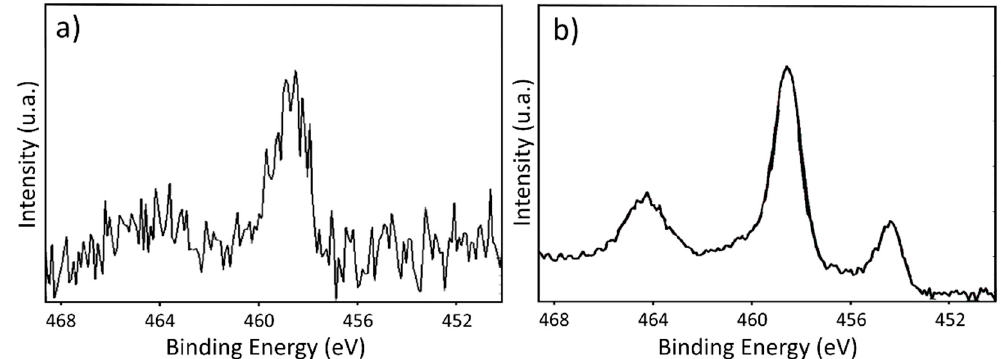
Figure 3. XPS high-resolution spectrum of the Ti region of the ABS: ( a ) before laser irradiation; ( b ) after green laser irradiation.